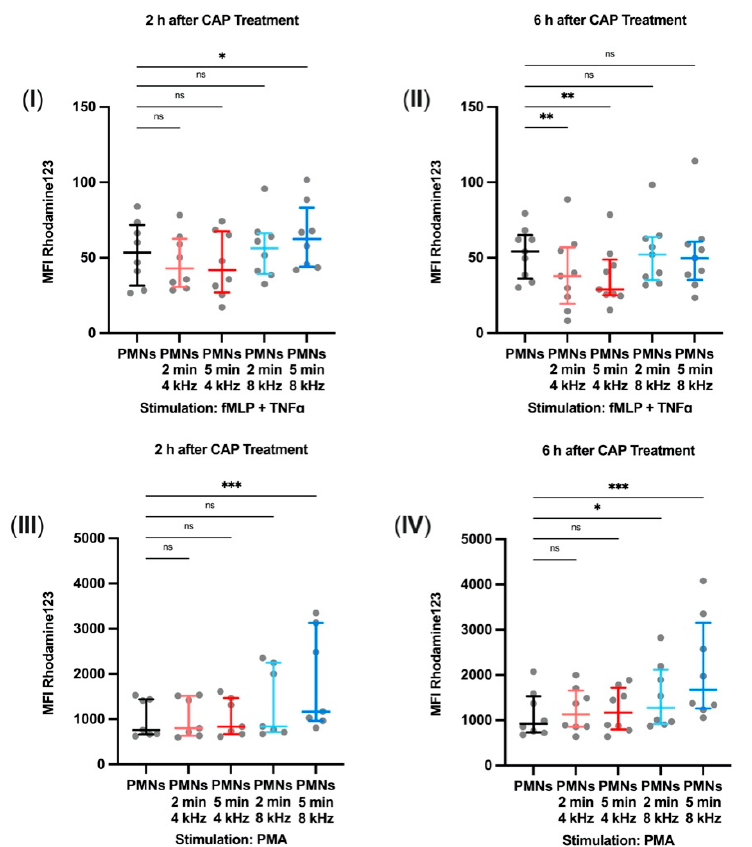
Figure 4. Changed activity of respiratory burst after CAP treatment. PMN respiratory burst activity after CAP treatment with 4 kHz or 8 kHz for 2 min and 5 min, measured by flow cytometry as median fluorescence intensity (MFI) of Rhodamine123. fMLP and TNF α stimulation ( I ) 2 h ( n = 8) and ( II ) 6 h ( n = 9) after CAP treatment. PMA stimulation ( III ) 2 h ( n = 7) and ( IV ) 6 h ( n = 8) after CAP treatment. Statistical analysis: Friedman test. * p < 0.05, ** p < 0.01, *** p < 0.001, ns: not significant.